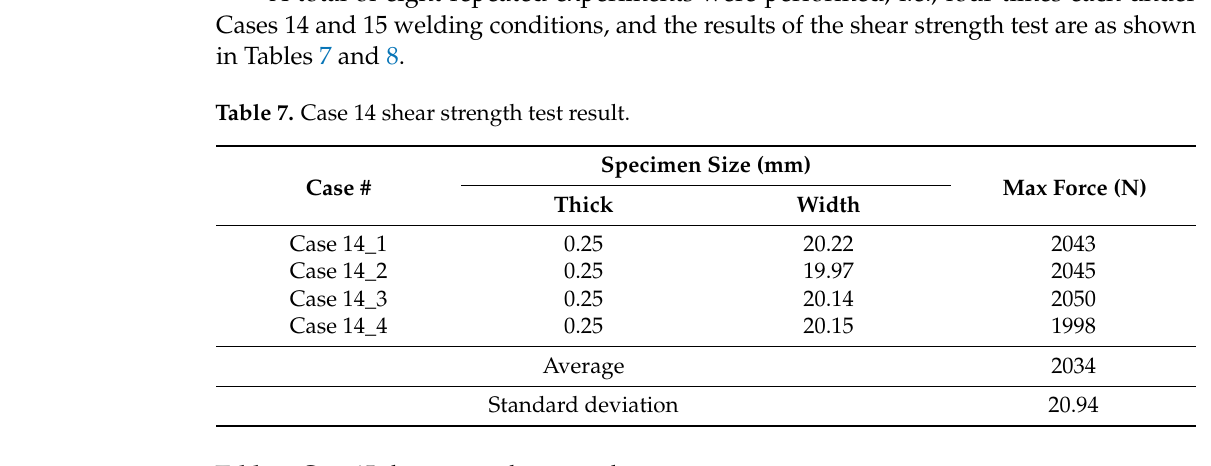
Table 8. Case 15 shear strength test result.